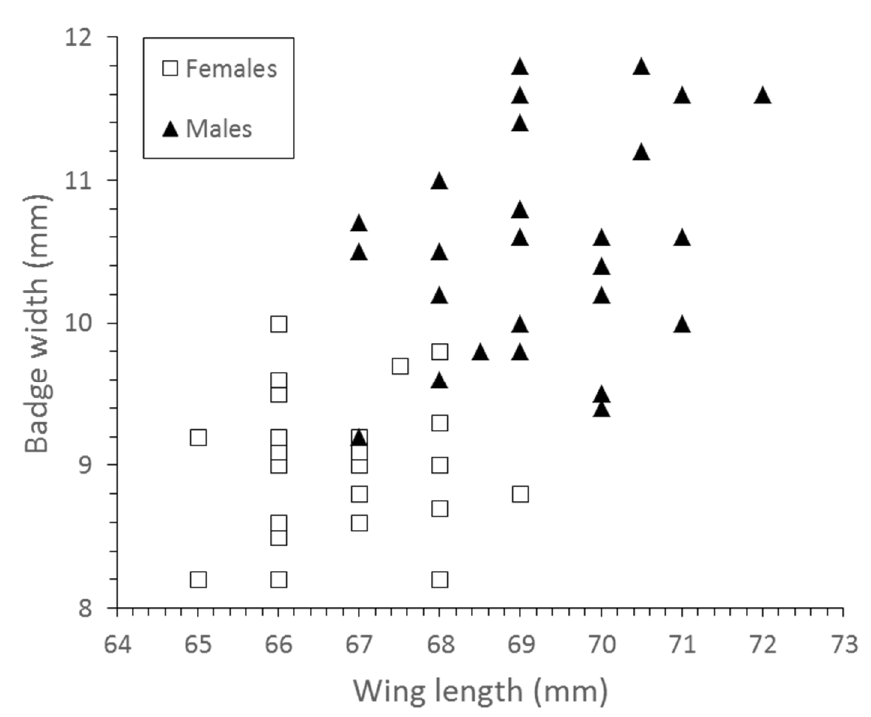
Figure 3. Morphological distribution of female and male Eurasian Tree Sparrows defined by the wing length and badge width.